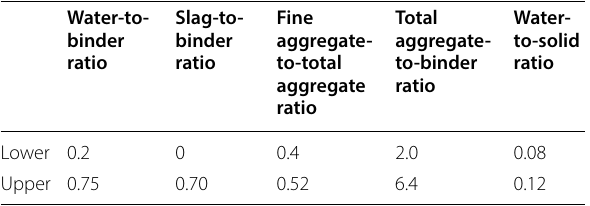
Table 3 Component ratio constraints. Water‑to‑